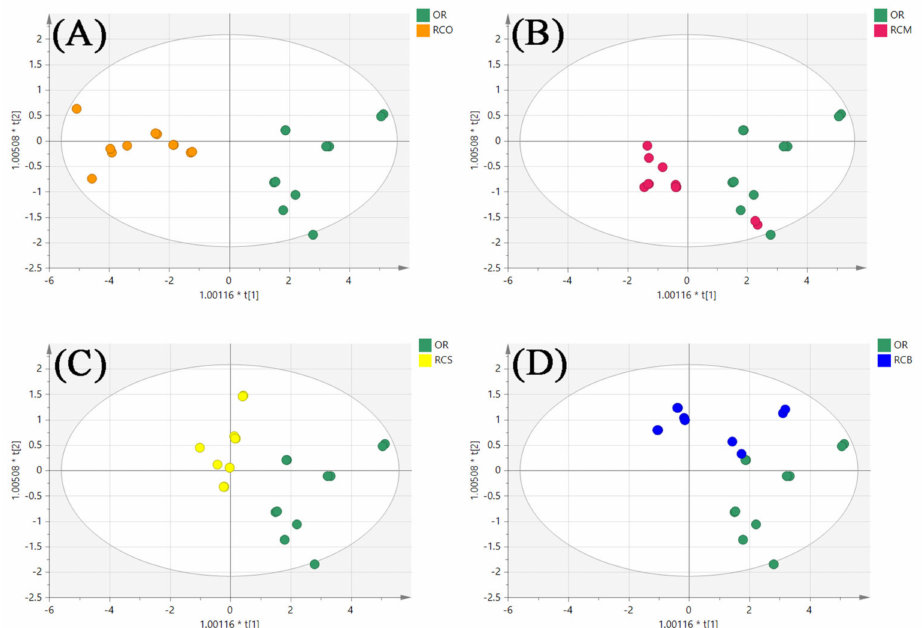
Figure 11. The OPLS-DA score plot of OR and other parts of Rana chensinensis . ( A ) OR and RCO. ( B ) OR and RCM. ( C ) OR and RCS. ( D ) OR and